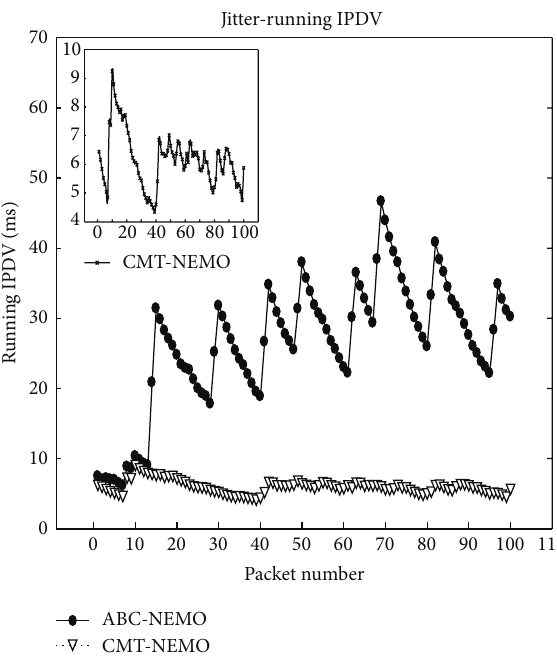
Figure 18: Comparison of HEVC at 763Kbps.